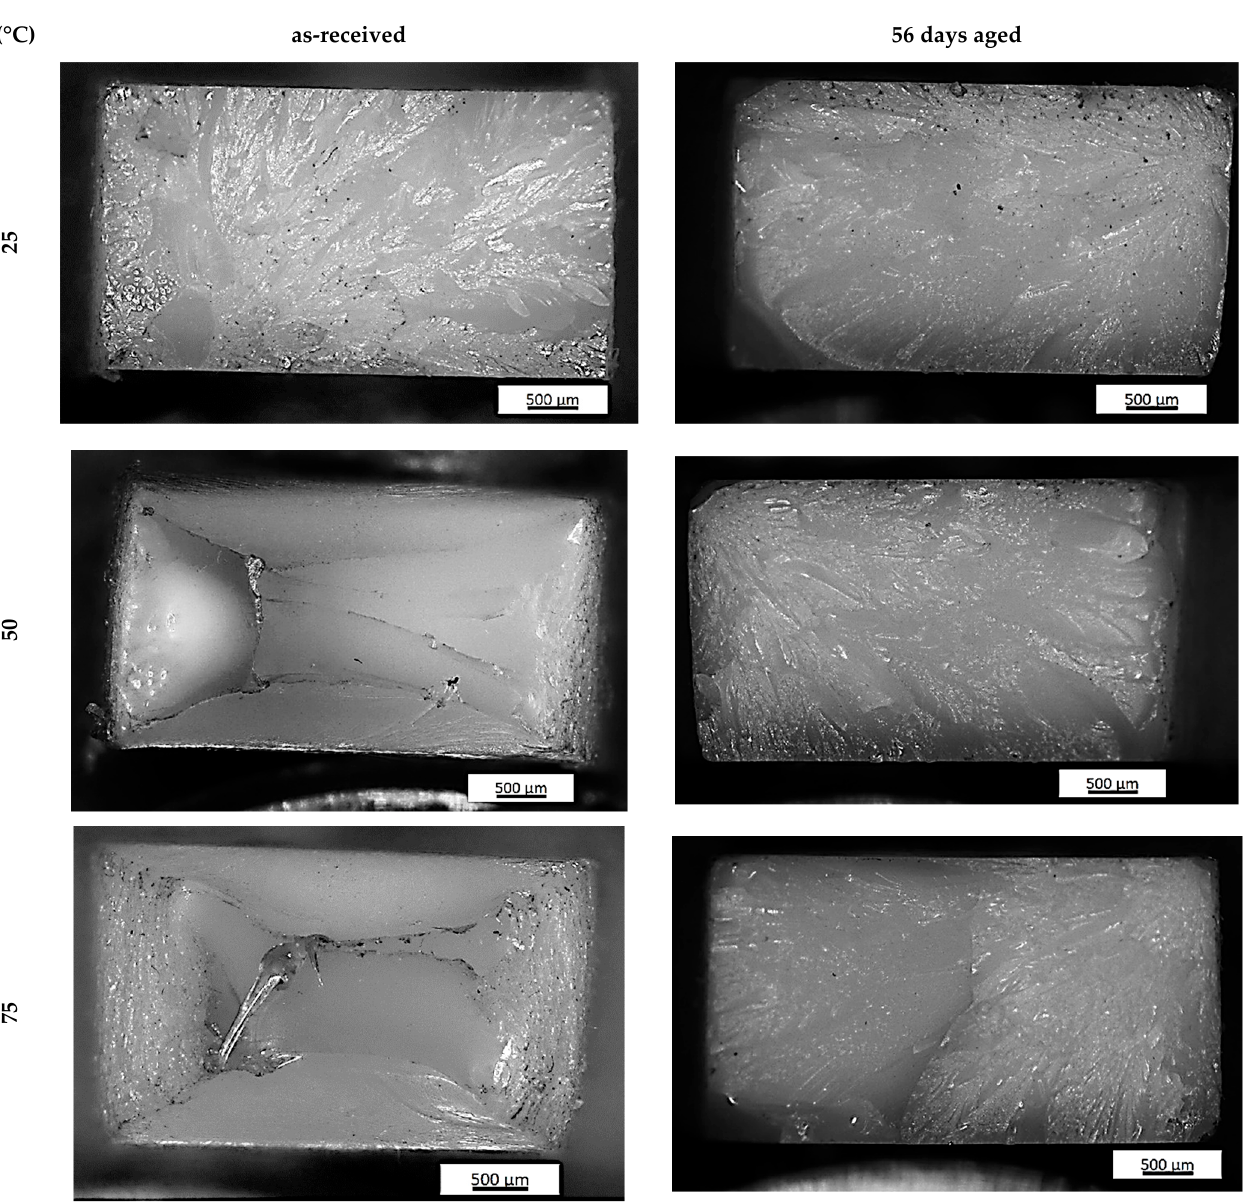
Figure 7. Photo of as-received PET and 56 days aged PET specimen fracture surface tested at different temperatures.